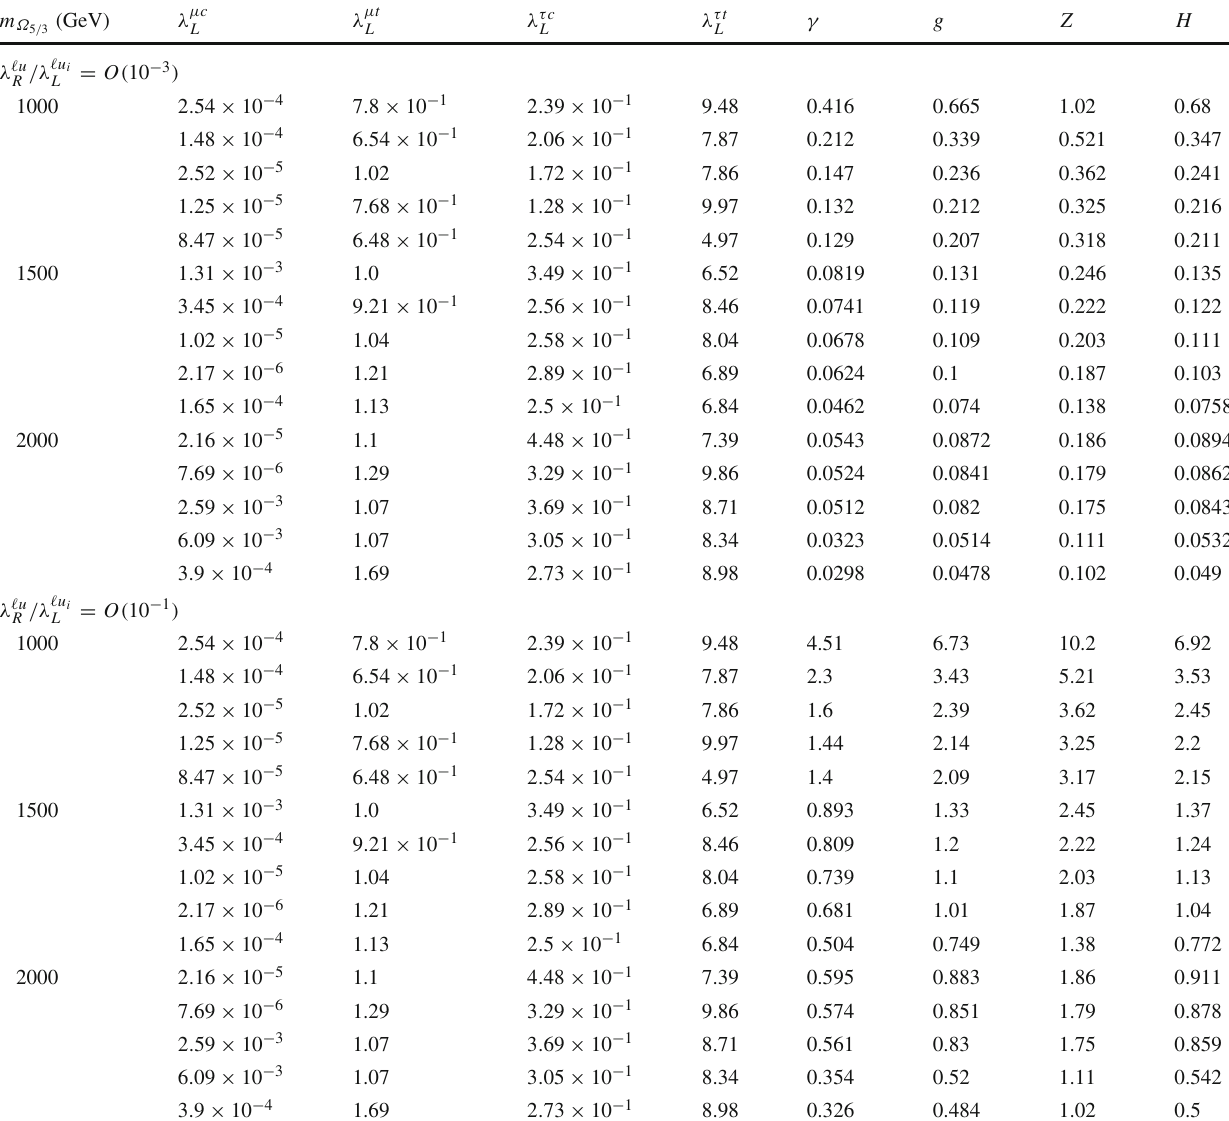
Table 1 Branching ratios of the t → cX decays for a few (λ μ